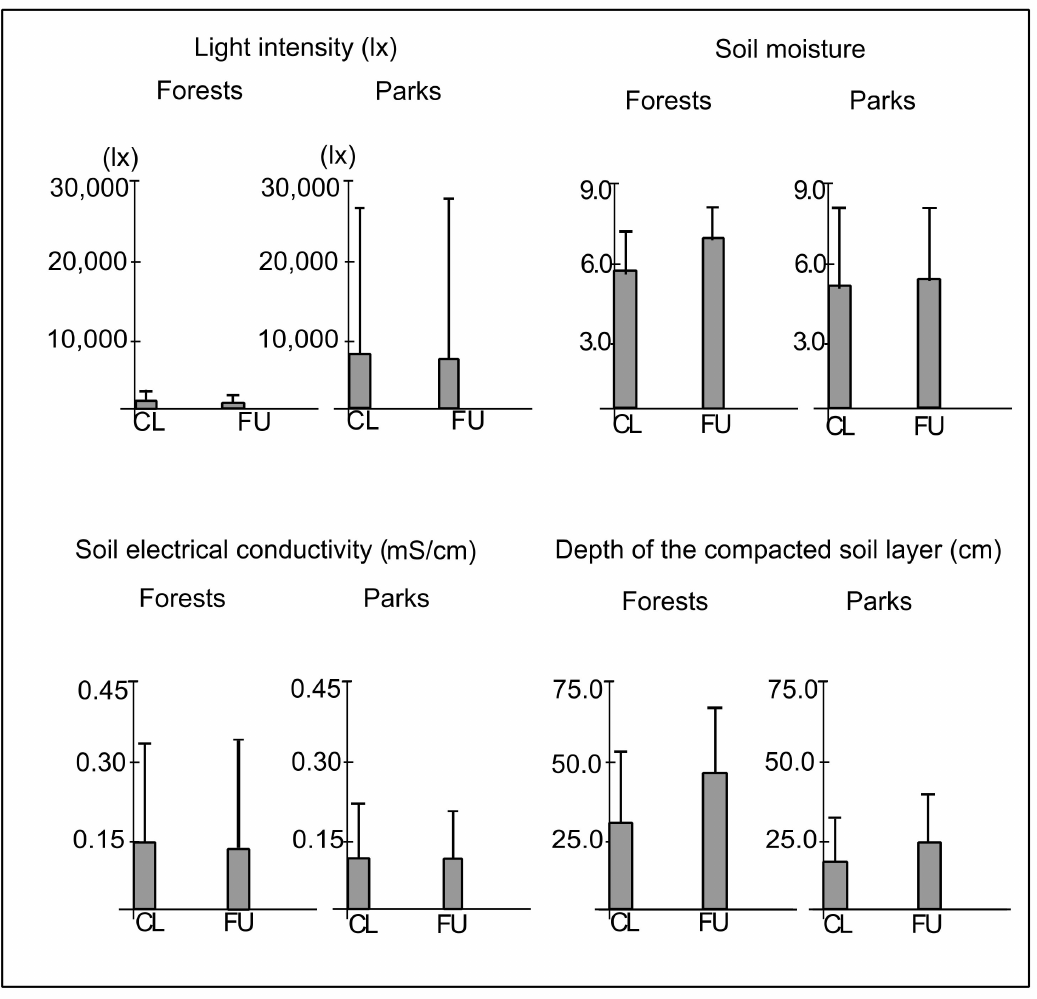
Figure 2. The mean (boxes) and standard deviation (whiskers) values of light intensity at ground level, soil moisture, soil electrical conductivity and depth of the compacted soil layer in closer (CL) and further (FU) plots located along paths in urban forests and